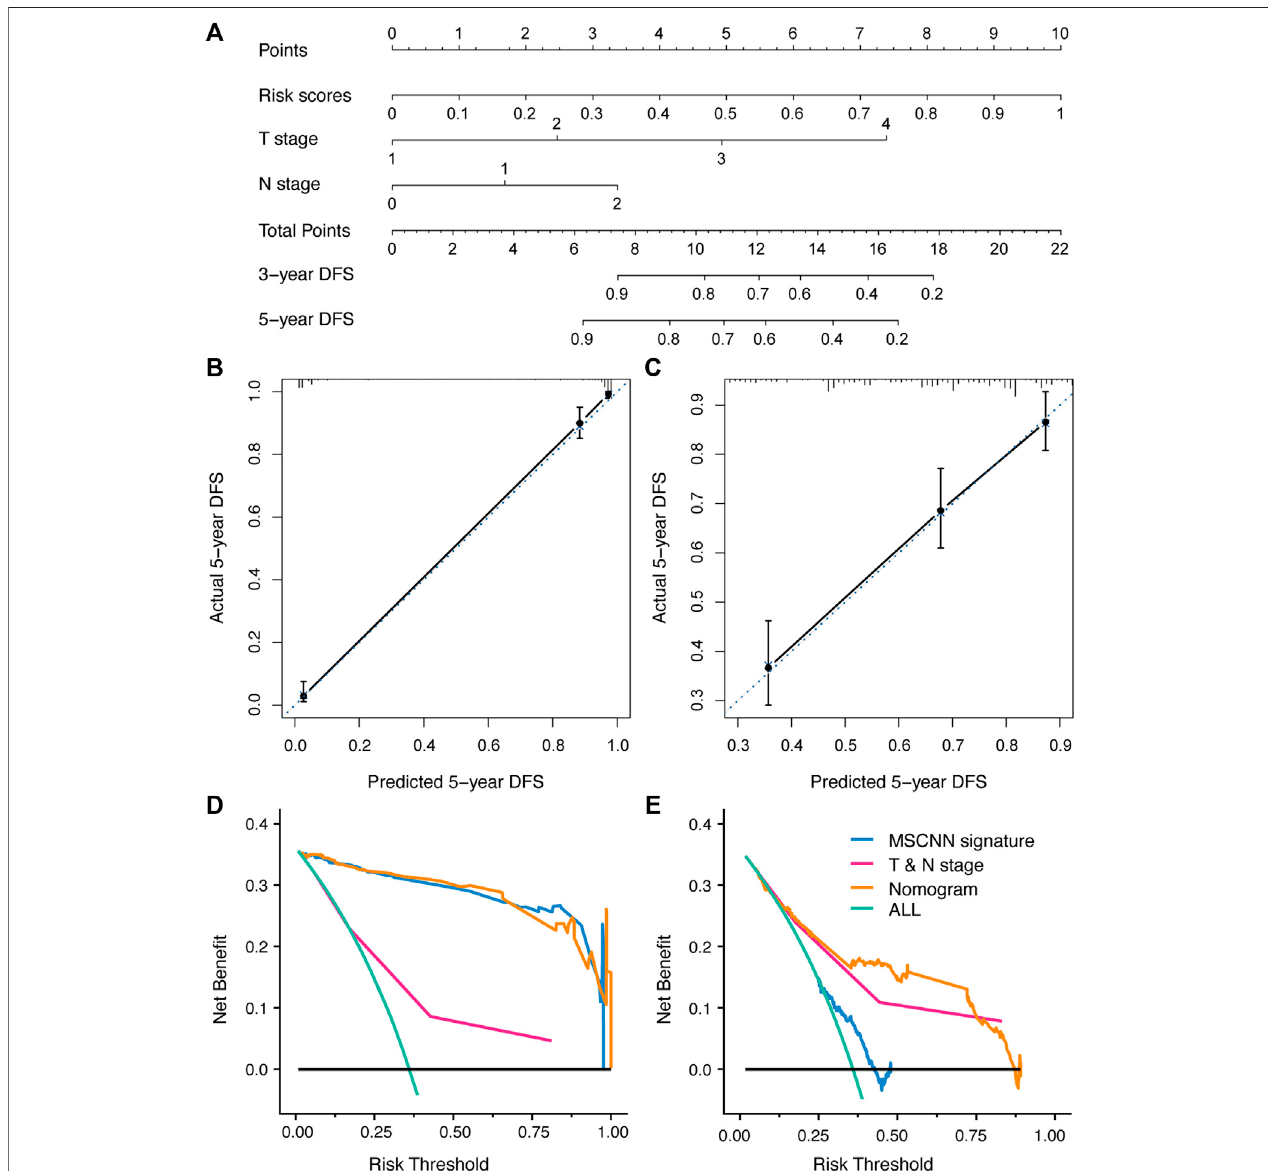
FIGURE 3 | The developed nomogram incorporated CT signature with T & N stage (A) . Coordinates length for each prognostic factor was determined by the coef fi cients of the cox regression model. For each patient, the total score was calculated with all variable scores. The probability of DFS was derived from the mapping relationship between the evaluation results and total score on speci fi ed patient survival time. (B,C) Calibration curves of nomogram for 5 years DFS in the development and validation cohort. (D,E) Decision curve analysis for nomogram established in the development and validation